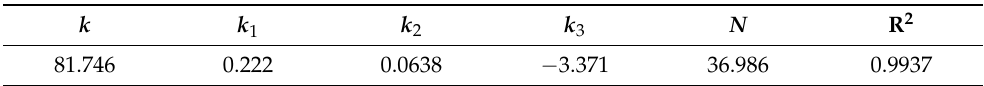
( b ) Variation trend of fatigue life with stress ratio. Figure 4. Fatigue life of the SFP mixture. Table 5. Fitting results of fatigue prediction model.